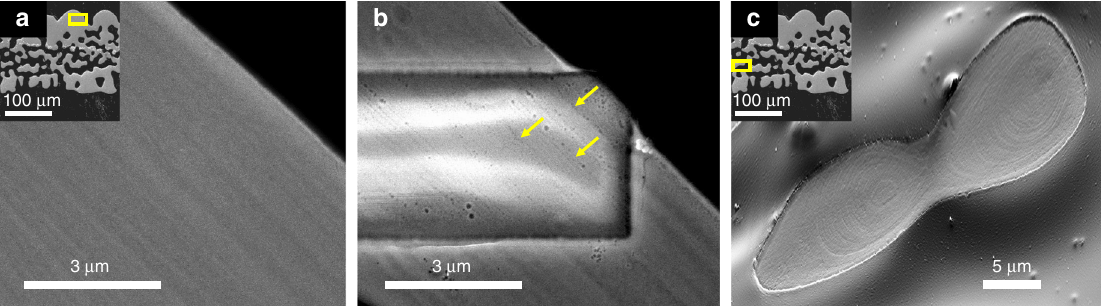
Fig. 3 The layered structure revealed by electron microscopy a HRSEM (BSE detector) image of a polished lens section. b BSE image of the same specimen after ion-milling in the FIB. Yellow arrows point at visible layers in the milled box. c HRSEM (secondary electron (SE) detector) images from polished DAP. The insets in a and c are a low magni fi cation image of the polished DAP, the yellow rectangles represent the corresponding areas of